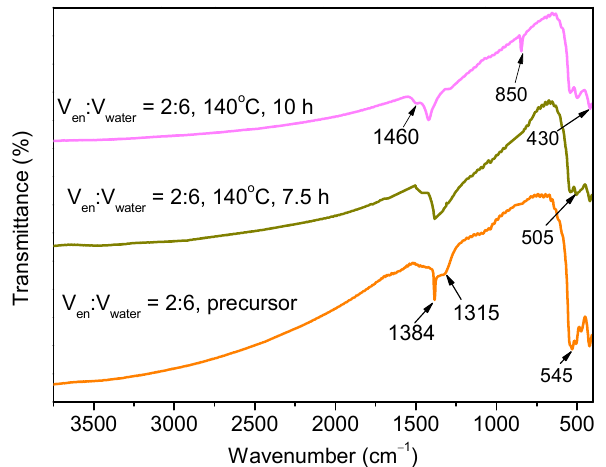
Figure 4. FT-IR spectra of the precursor and the samples obtained at 140 °C for 7.5 h and 10 h in the ethylenediamine–water mixture with a V en :V water ratio of 2:6. Based on the XRD and FT-IR analyses, formation of the Bi 2 O 2 CO 3 /α-Bi 2 O 3 composite in the present solvothermal process could be described by following reactions: 2OHHNCHCHNHO2HNHCHNCHH 322322222